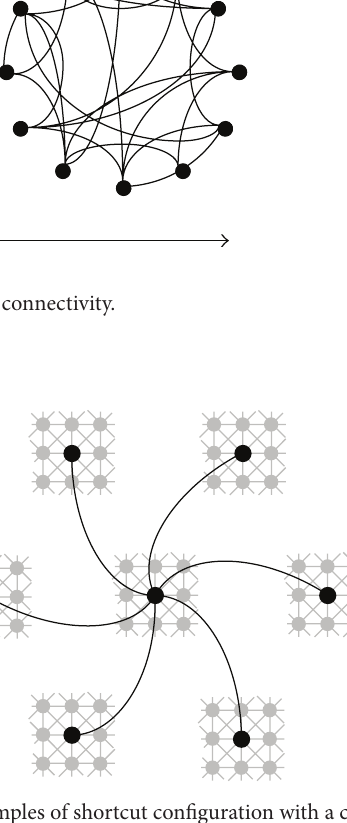
Figure 3: Examples of shortcut configuration with a center